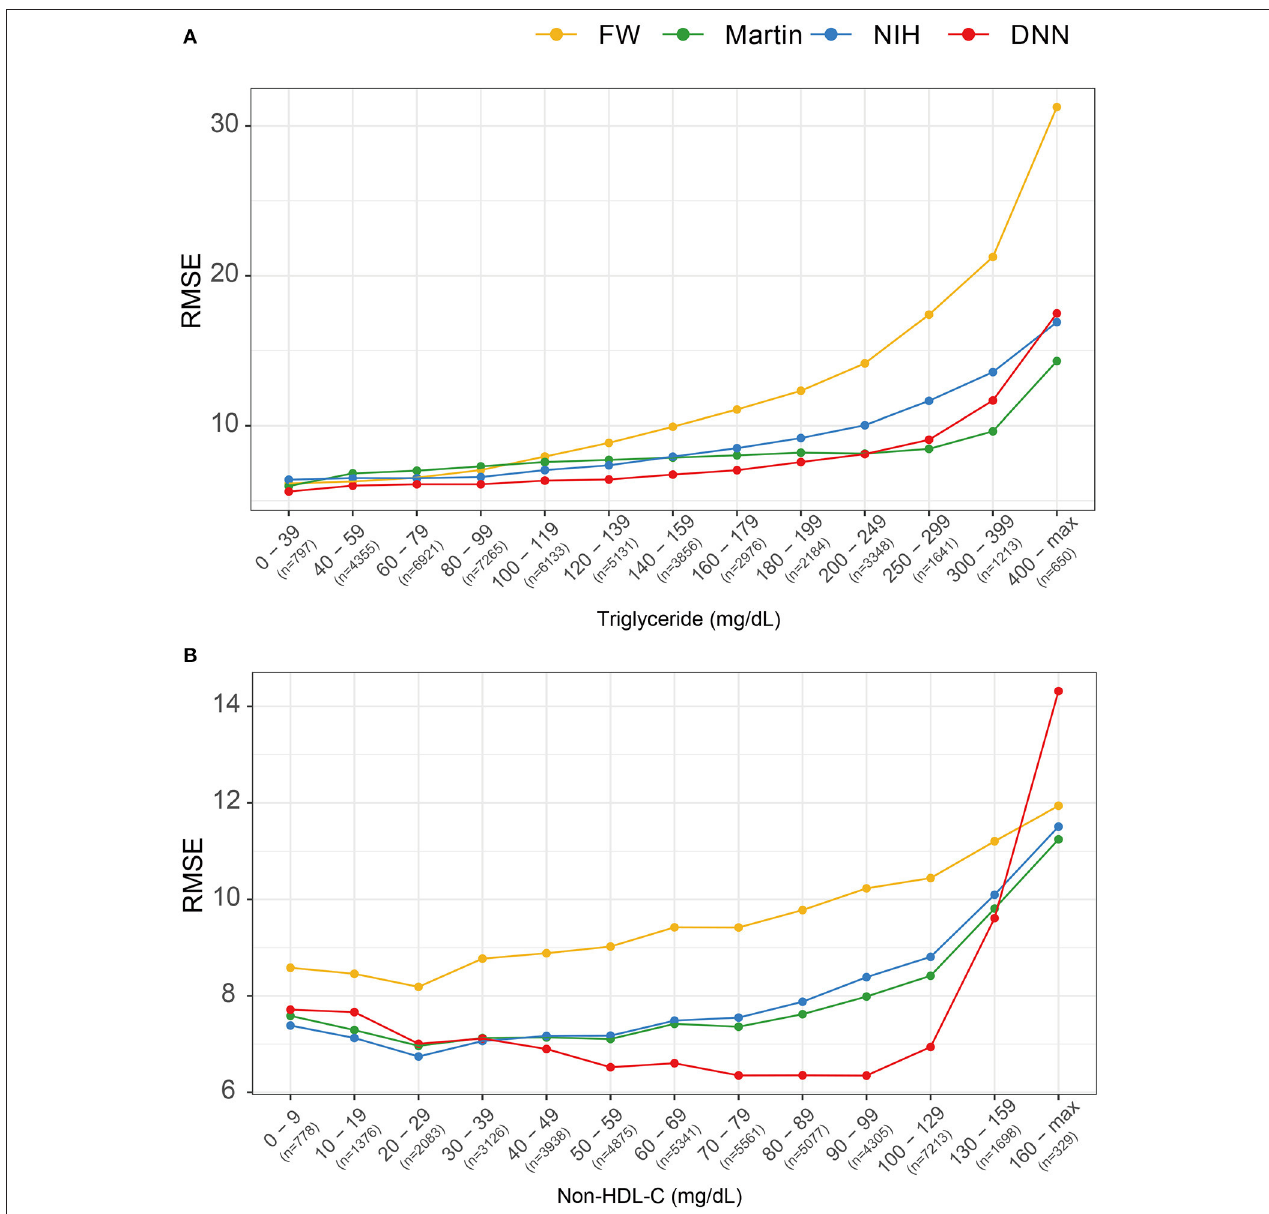
FIGURE 6 | Comparison of root mean-square errors (RMSEs) for four LDL estimation models. (A) RMSEs for four LDL estimation models according to triglyceride classification. (B) RMSE for the four LDL estimation models according to non-HDL cholesterol